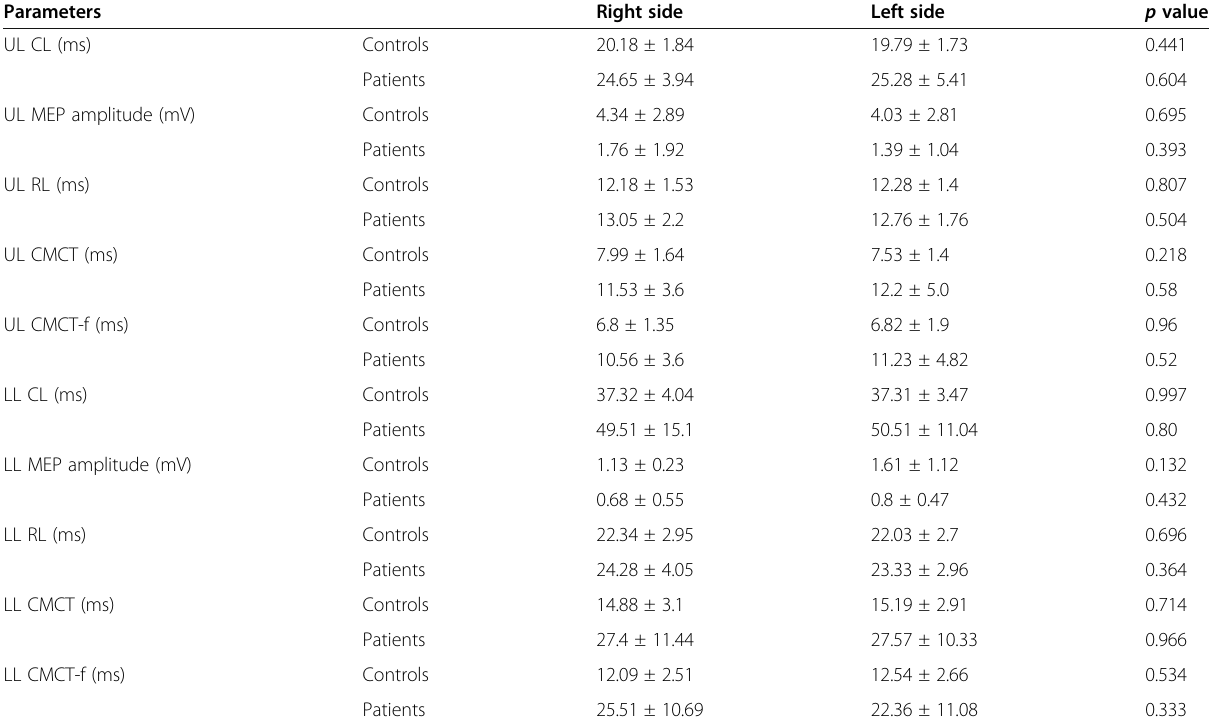
Table 2 TMS parameters of patients with multiple sclerosis and controls